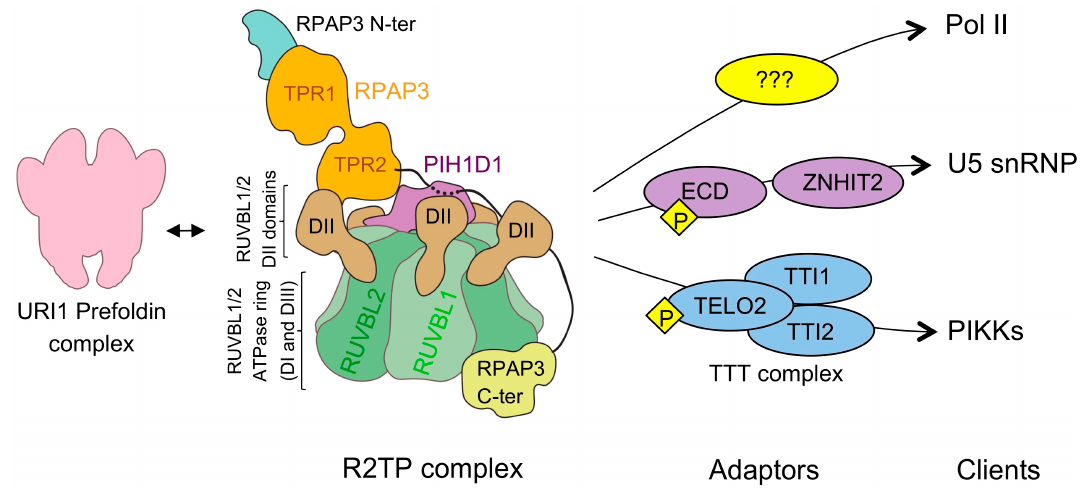
Figure 1. The R2TP-based chaperone system. The cartoon represents the R2TP complex and its constituent proteins. The RUVBL1-RUVBL2 complex (labeled as RUVBL1 / 2 in the figure for simplicity) forms a hexameric ring that contains the ATPase domains and made of domains I (DI) and III